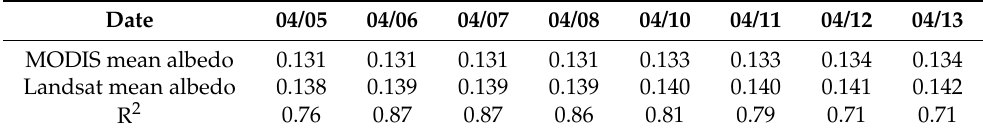
Table 6. Statistical results of the mean albedo of the two products, and the correlation between two products’ variation in the eight days adjacent to 9 April 2014 at GWN (Figure